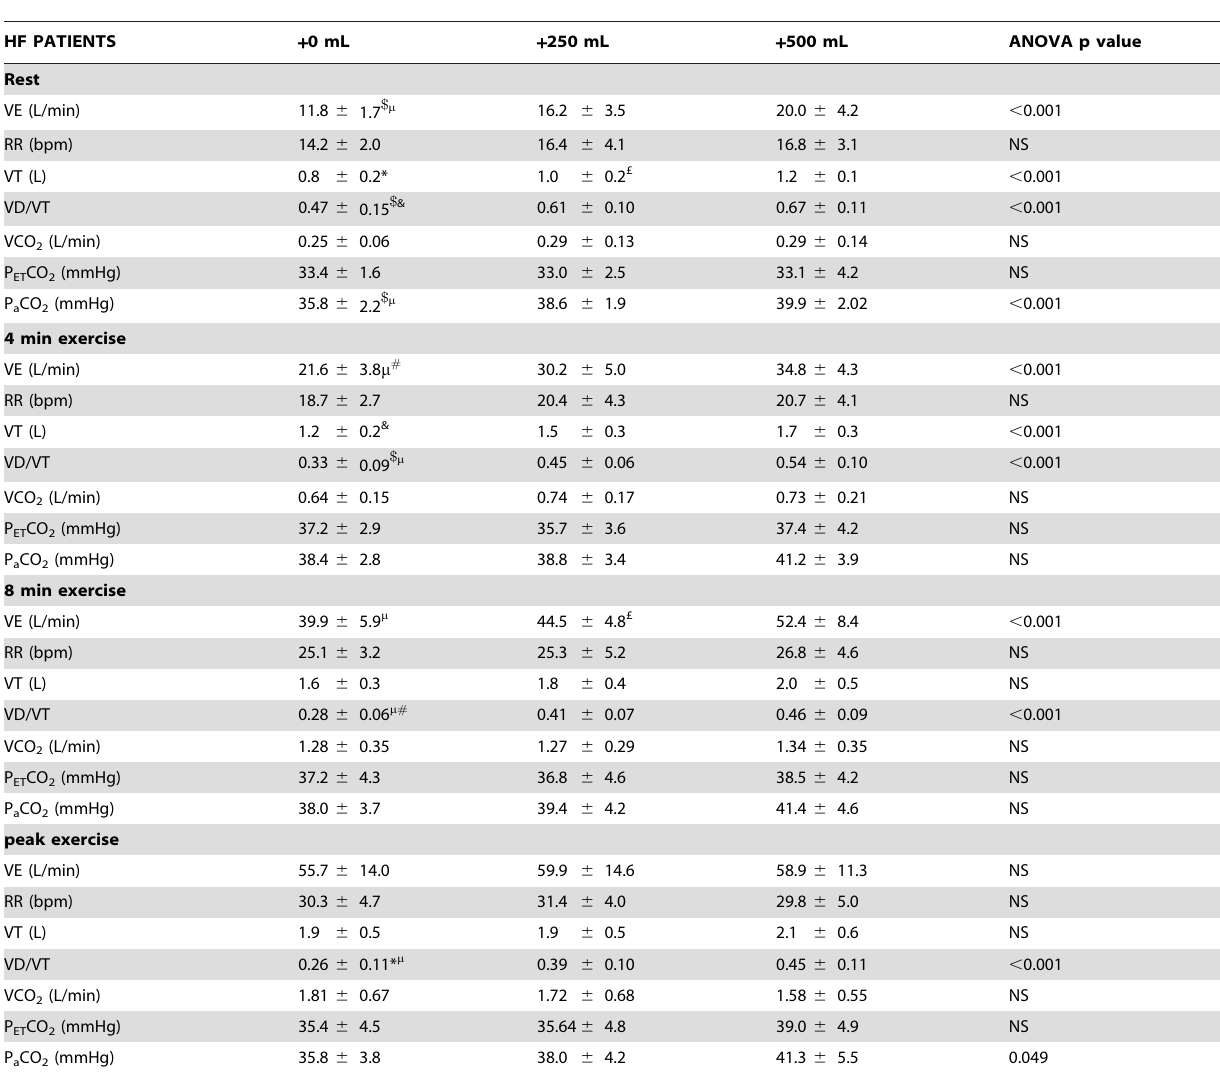
Table 3. Ventilatory parameters in heart failure patients with 0, 250 and 500 mL of additional dead space.